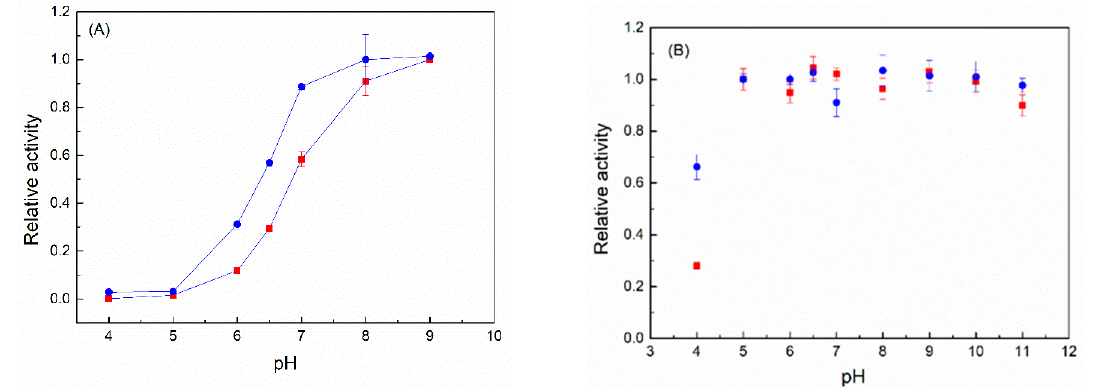
Figure 8. ( A ) Activities of ( ■ ) free and ( ● ) immobilized NPD with 24 h on agarose-glyoxyl at 25 °C and different pHs and ( B ) profile of residual enzymatic activity, measured under standard conditions (hydrolysis of 0.36 mM BTEE solution at 25 °C and pH 7.0 for 5 min, Section 2.2), after 4 h of incubation at different pH values.